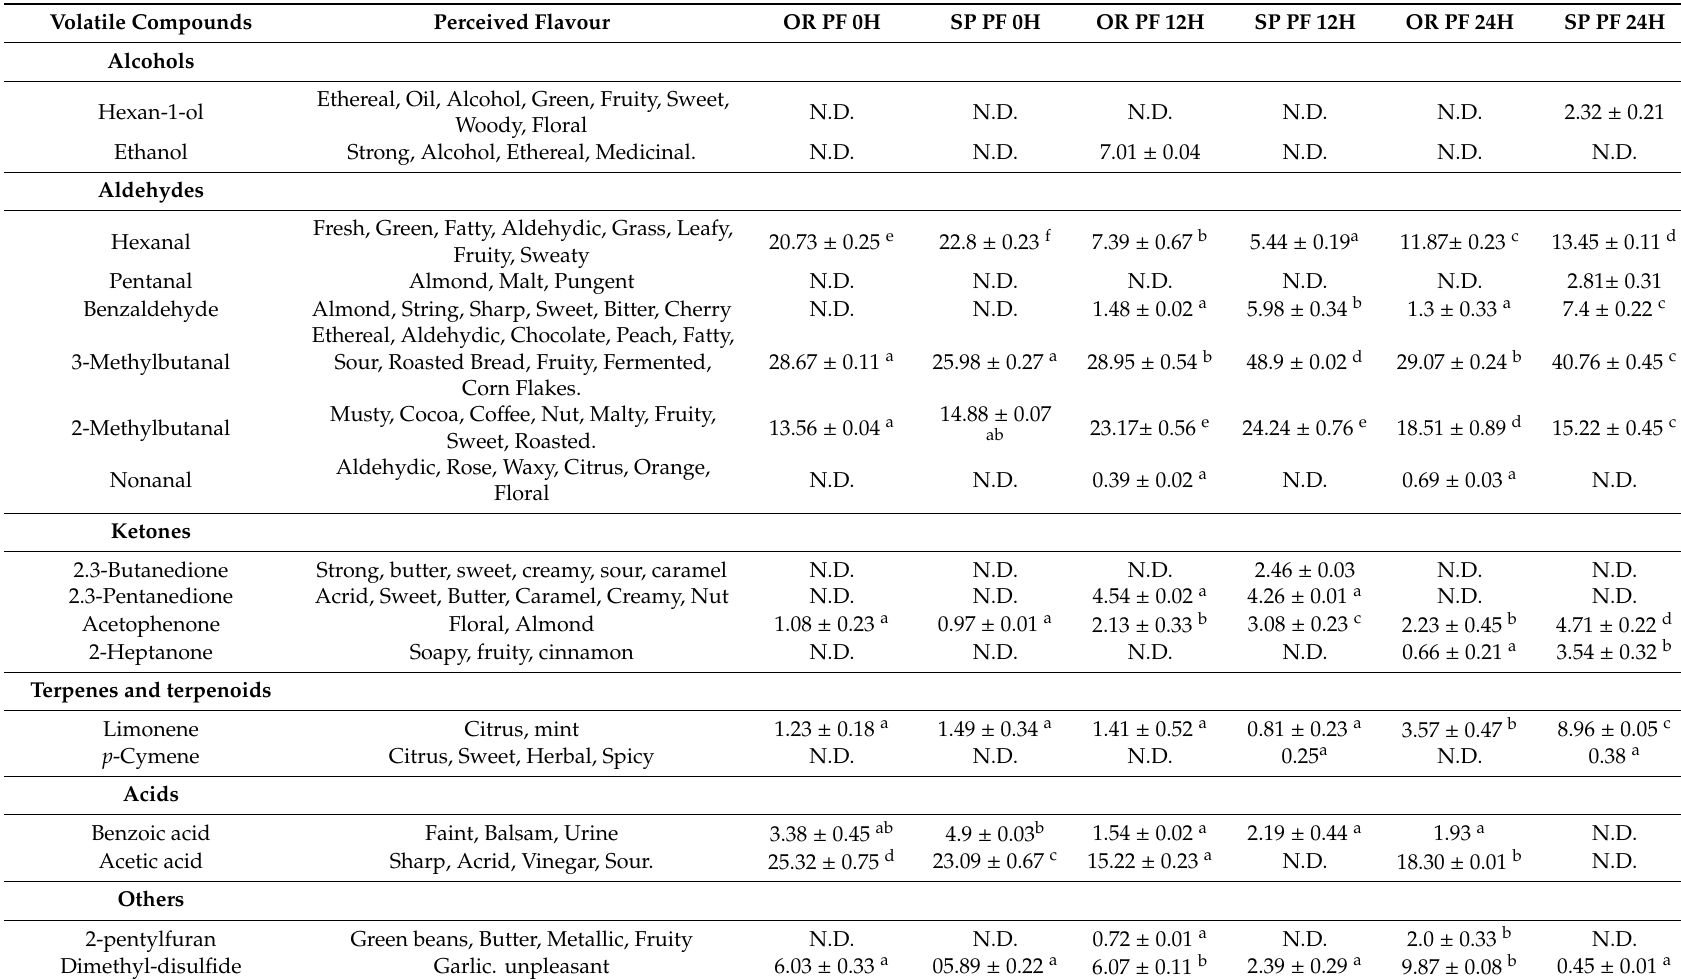
Table 7. Aroma compounds of the final baked mu ffi ns fermented with OR and SP sourdoughs at di ff erent fermentation times: 0 h, 12 h, 24 h